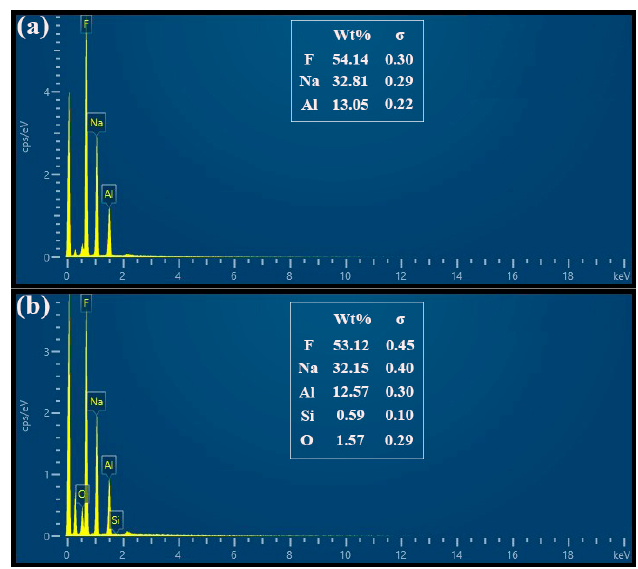
Figure 15. EDX analysis of ( a ) commercial cryolite and ( b ) as-synthesized cryolite.